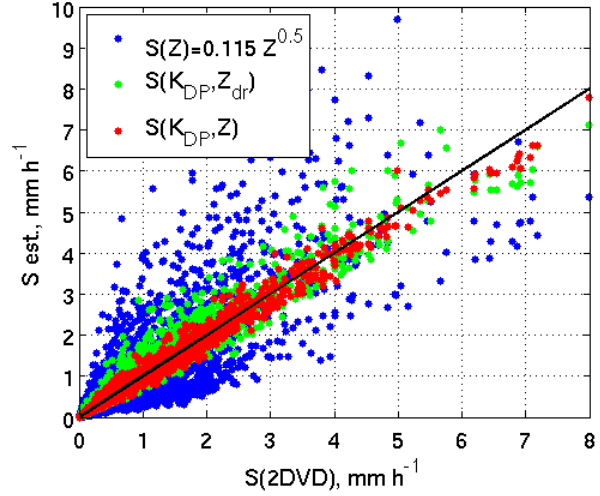
Figure 15. Scatterplots of snow water equivalent rates measured by disdrometer during 16 Oklahoma snow events versus their estimates from the S ( Z ) , S ( K DP ,Z ) , and S ( K DP ,Z dr ) relations.